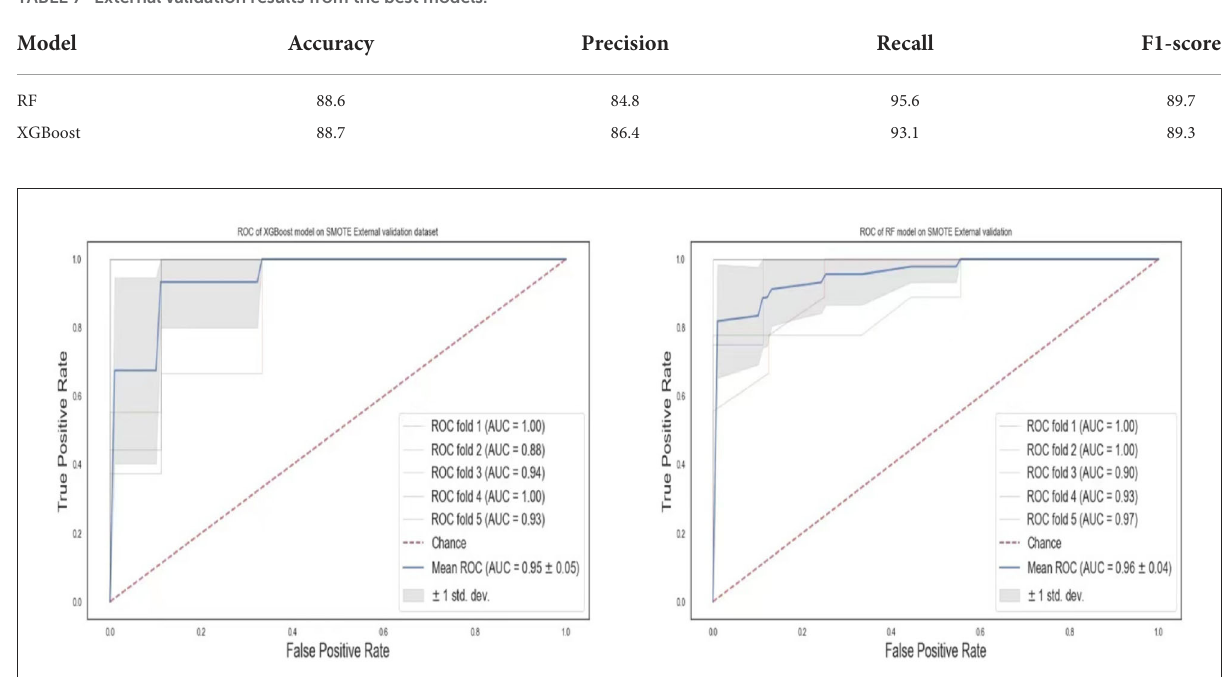
TABLE 7 External validation results from the best models.